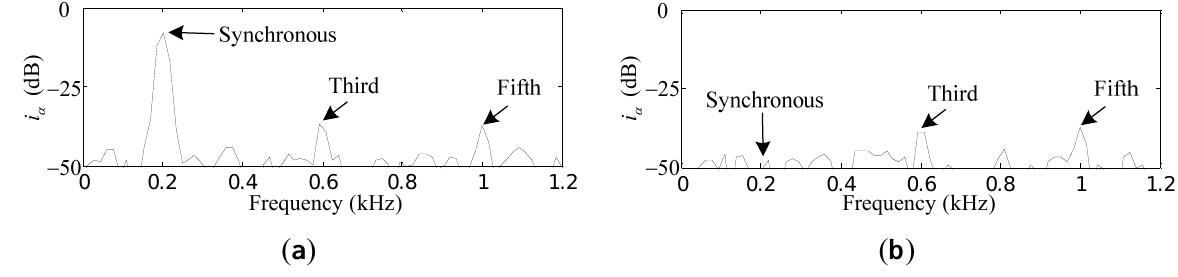
Figure 14. Simulation results of i α : ( a ) before synchronous current reduction; ( b ) after synchronous current reduction.